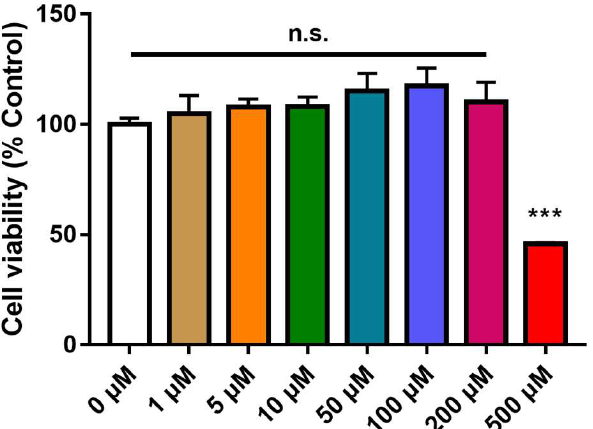
Figure 2. Cytotoxic effect on bone-marrow derived macrophages (BMDMs) by LOBE. BMDMs were treated with pre-determined concentrations of LOBE (0, 1, 5, 10, 50, 100, 200, and 500 µM) for 24 h. Adherent or living cells were counted using cell viability kit and normalized to control group as 100%. Results are the mean ± standard deviation (SD) of triplicate experiments: not significant (n.s.), *** p < 0.001, significant difference as compared to the control group and each group by a one-way analysis of variance (ANOVA) followed by Tukey’s post hoc analysis.